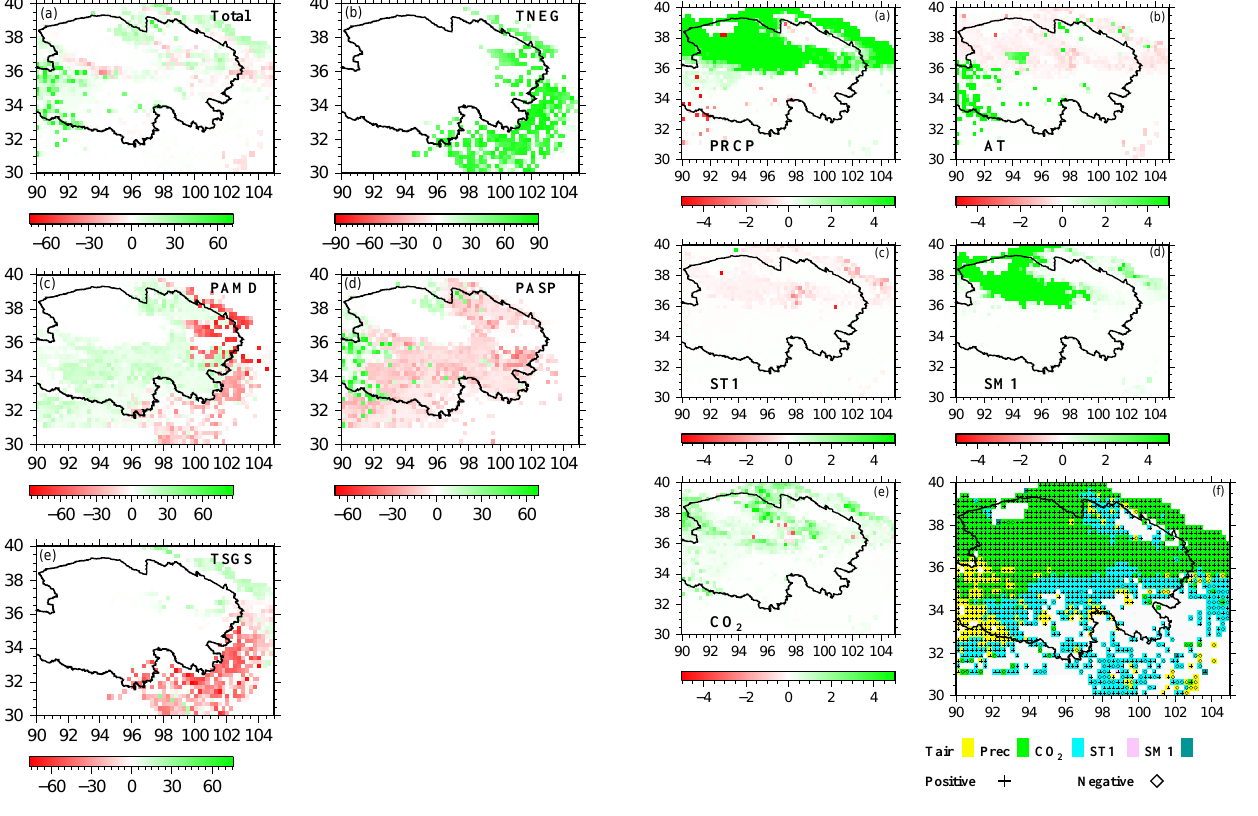
Figure 7. Differences (%) in total FPC and individual FPCs be- tween historical climate simulation and trend-removed climate sim- ulation.